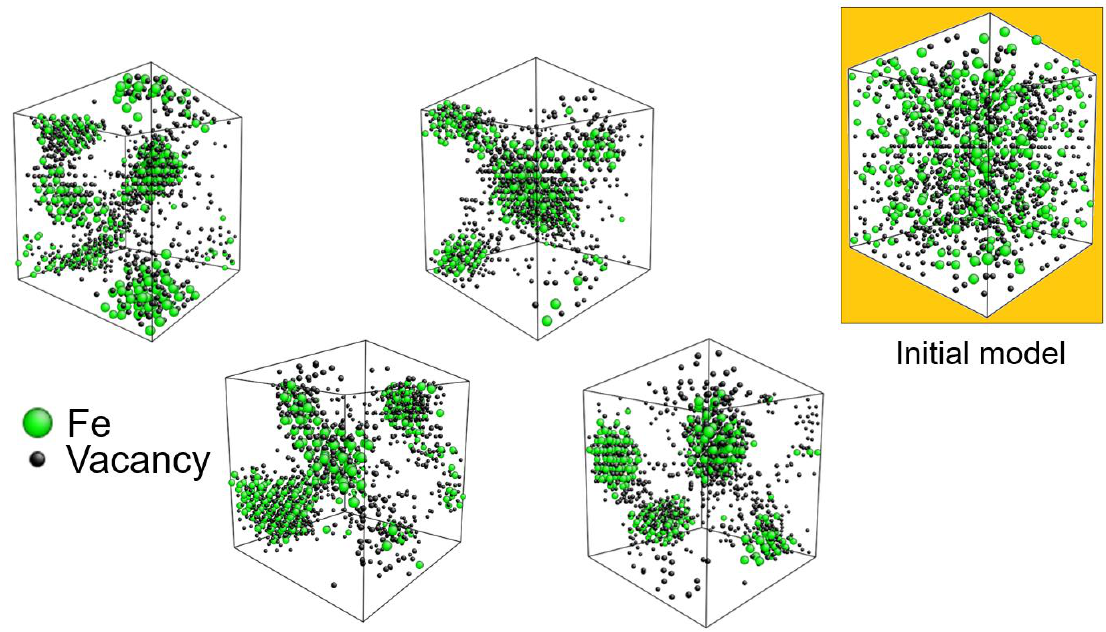
Figure 10. Models from different RMC modelling runs showing clusters of Fe atoms and vacancies. A randomized model used as starting point for RMC simulations is shown inset for comparison. Ti and V are not shown for clarity.